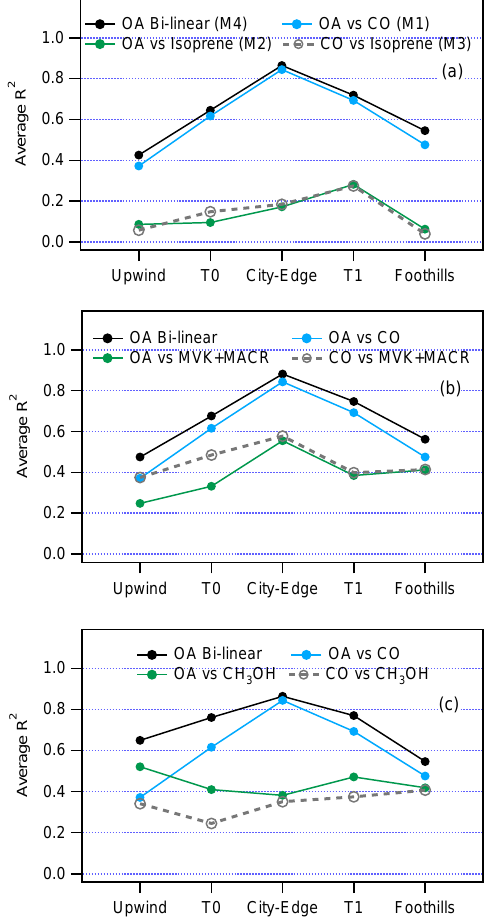
Figure 2. Average coefficient of determination ( R 2 ) for bilinear or linear least-squares regressions using data from five locations for plume transects shown in Fig. 1. Explanatory variables are (a) CO and isoprene, (b) CO and MVK + MACR, and (c) CO and CH 3 OH. Panel (a) gives regression model in